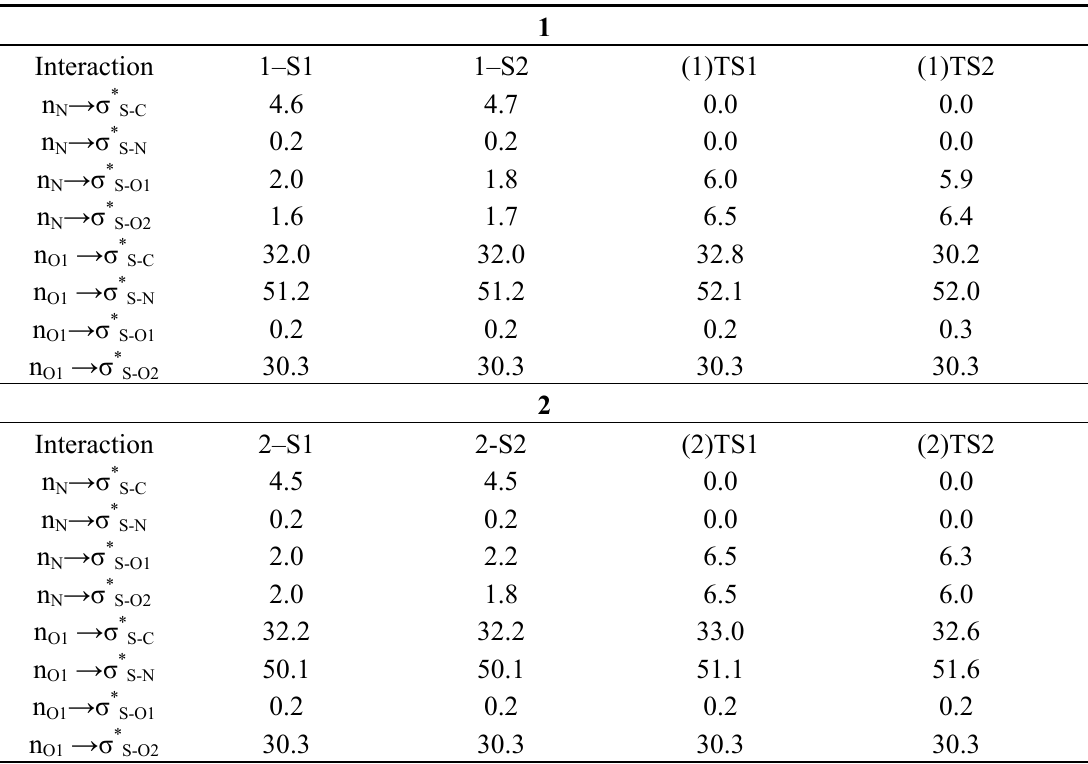
Table 4. Stabilization energies (kcal·mol − 1 ) of hyperconjugative interactions in the sulfonylgroup a,b